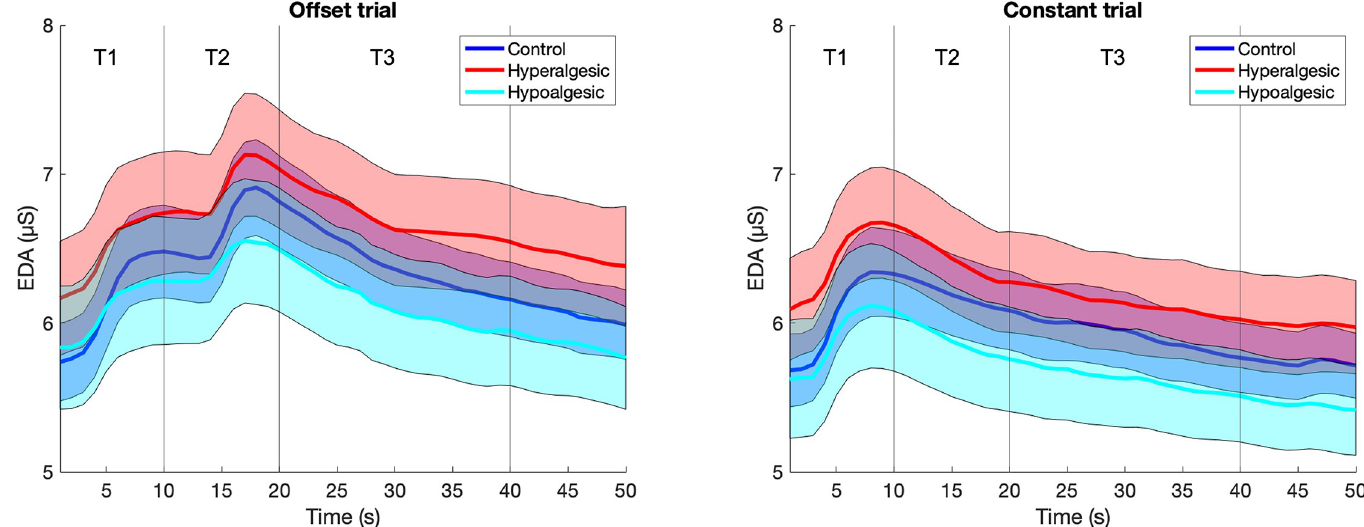
Fig 4. Electrodermal activity (EDA) in offset analgesia (left) and constant trials (right). Compared to constant trials, offset analgesia produced paradoxically higher EDA levels during the T3 interval. Bold curves represent mean pain whereas shaded zones are standard errors of the mean (SEM). Vertical markers separate T1, T2 and T3